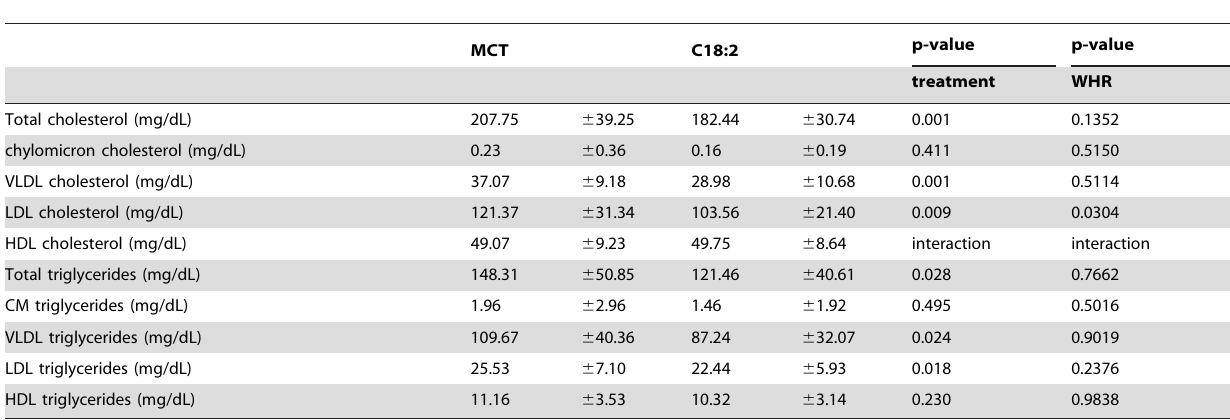
Table 2. HPLC lipoprotein measurements after both treatments, analyzed by two-way ANOVA for treatment and waist-hip-ratio differences (mean 6 sd).